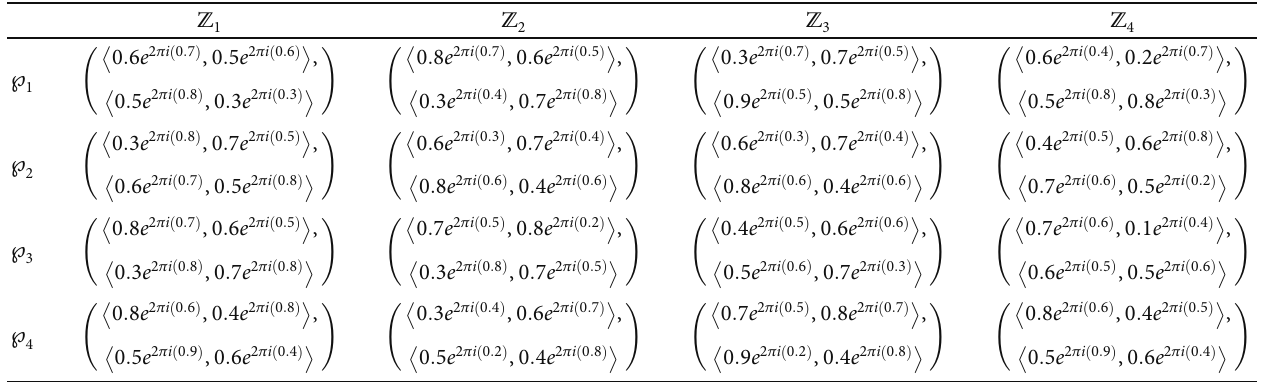
Table 1: Cq-ROFR information given by expert E 1 .